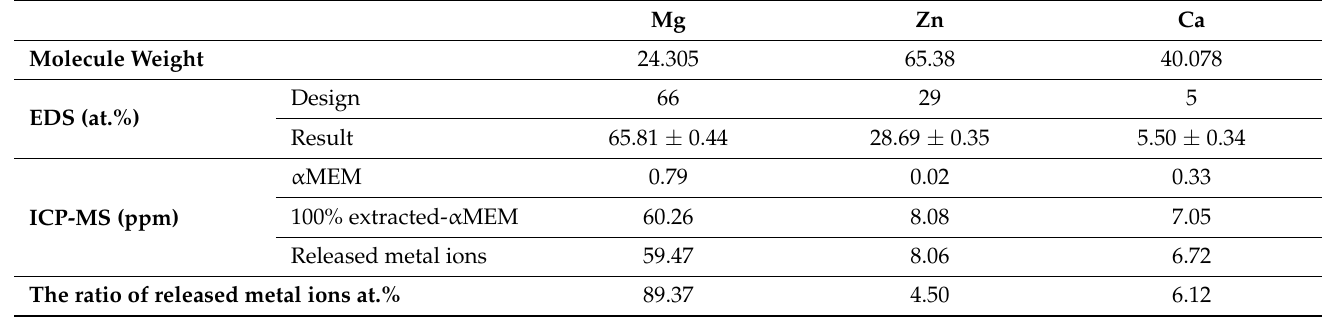
Table 1. Chemical composition of Mg 66 Zn 29 Ca 5 bulk metallic glass and metal ions measurements in α MEM and extracted- α MEM (mean ± standard